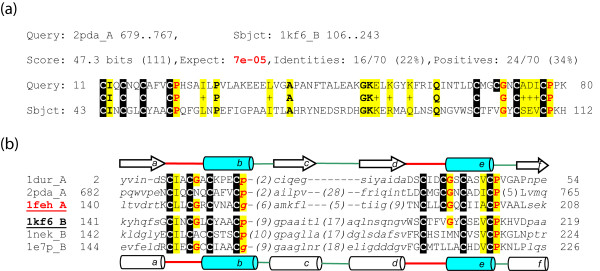
Sequence alignment of the ferredoxin domains: a) PSI-BLAST alignment of a bacterial ferredoxin domain (2pda, chain A: 679–767) with a α-helical ferredoxin domain (1kf6). The cluster-binding residues are boxed in black. Small residues near the ligand-binding site are colored red. Similar residues are colored yellow. b) Multiple structure-based sequence alignment of bacterial ferredoxins and α-helical ferredoxins. The consensus secondary structures for the two types of ferredoxins are shown: α-helices as cylinders and β-strands as arrows. The multiple alignment was made by manually defining equivalent residues for the structurally similar regions of the ferredoxin domains. Sequences shown in capitals correspond to the structurally superimposed regions. Regions that are not superimposable due to structural differences are shown in italics. The PDB code and the domain range are shown. The structures of 1feh (red) and 1kf6 (black) correspond to the superposition in figure 1e. Residues are colored according to figure 2a.